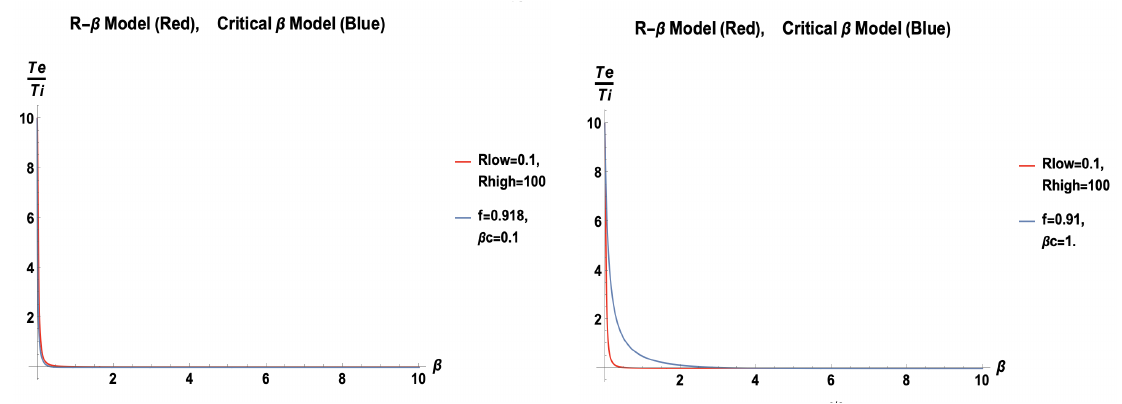
Figure 1. Electron-to-proton temperature ratio variation between T e / T i = 10 and ∼ 0 for the R- Beta and Critical Beta Models as a function of β . The electron-to-ion temperature ratio varies as − β / β c T e / T i = 1 for the R- β Model and fe for the Critical Beta Model. For ( 1 + β 2 ) − 1 R low +( 1 + β 2 ) − 1 β 2 R high 1 − fe − β / β c the R-Beta parameters ( R low , R high ) = ( 0.1,100 ) and Critical Beta parameters ( f , β c ) = ( 0.918,0.1 ) ( Left ), the models nearly coincide. For the R-beta parameters ( R low , R high ) = ( 0.1,100 ) and Critical Beta parameters ( f , β c ) = ( 0.91,1 ) ( Right ), the Critical Beta model has a softer